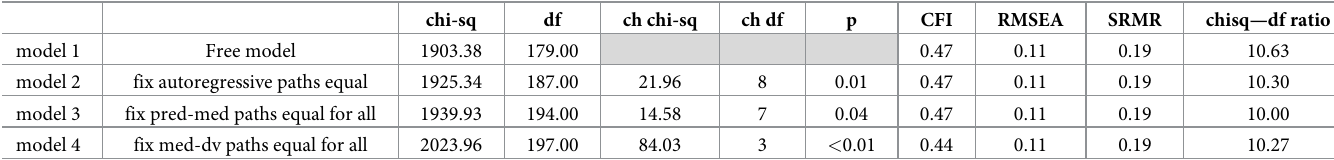
Table 6. Path analysis model comparisons, testing stationarity of hypothesised model.